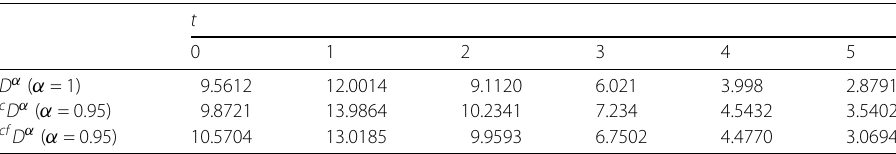
Table 2 Comparison between the standard derivative, Caputo fractional derivatives, and Caputo–Fabrizio fractional derivative for E ( t ) t